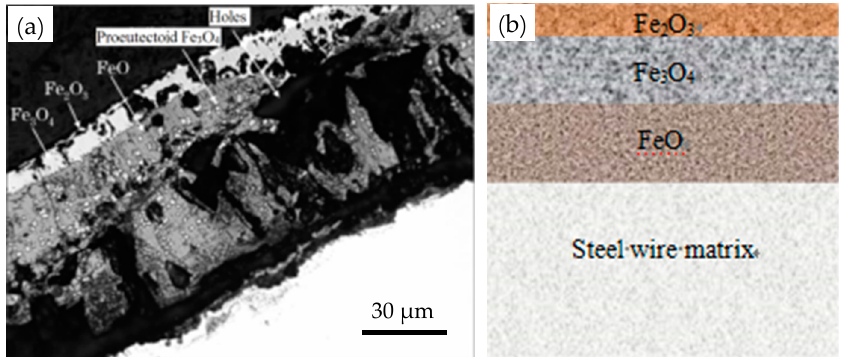
Figure 7. Structure of the oxide scale on the surface of a wire rod for a steel cord: ( a ) image under a scanning electron microscope and ( b ) a schematic diagram. Reprinted with permission from ref. [14].